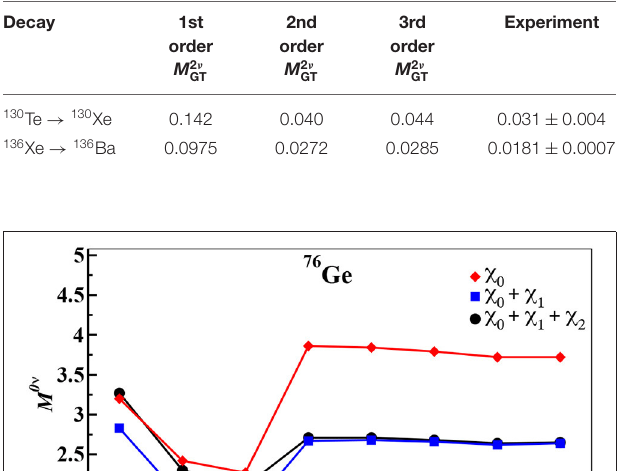
Frontiers in Physics |